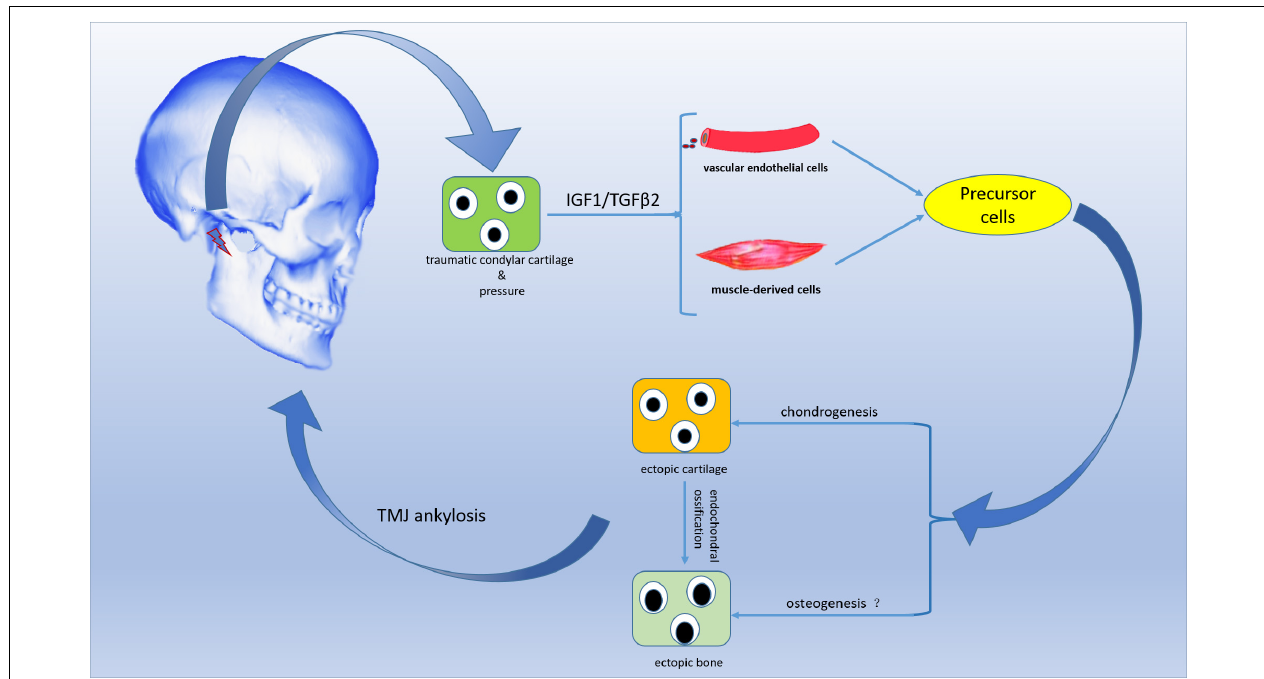
FIGURE 10 | Schematic diagram of the proposed development process of THO-TMJ. Trauma in the TMJ region stimulates residual and injured chondrocytes to release IGF1/TGF β 2 when there is no articular disc (and under pressure). IGF1/TGF β 2 may induce blood endothelial cells and muscle-derived cells to differentiate into chondrocytes, followed by heterotopic ossification through an endochondral ossification process. Finally, heterotopic ossification may lead to TMJ ankylosis in the clinic. “?” indicates that precursor cells may also directly differentiate into osteoblasts, but this needs to be further